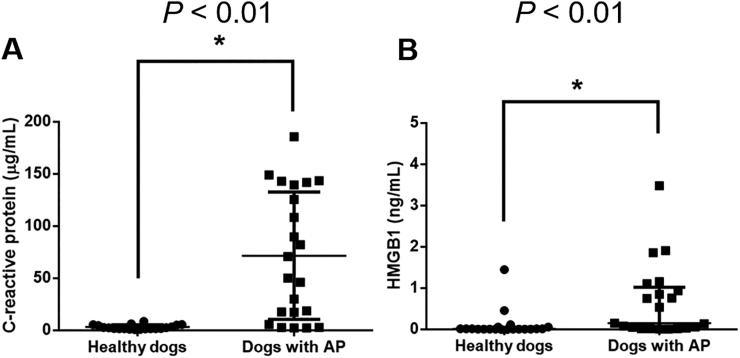
Comparison of the serum concentrations of (A) C-reactive protein and (B) HMGB1 between dogs with AP (n = 22) and healthy dogs (n = 20) at hospital admission. The horizontal bars indicate the medians and interquartile ranges. *P < 0.05 (Mann–Whitney U test). HMGB1, high mobility group box 1.